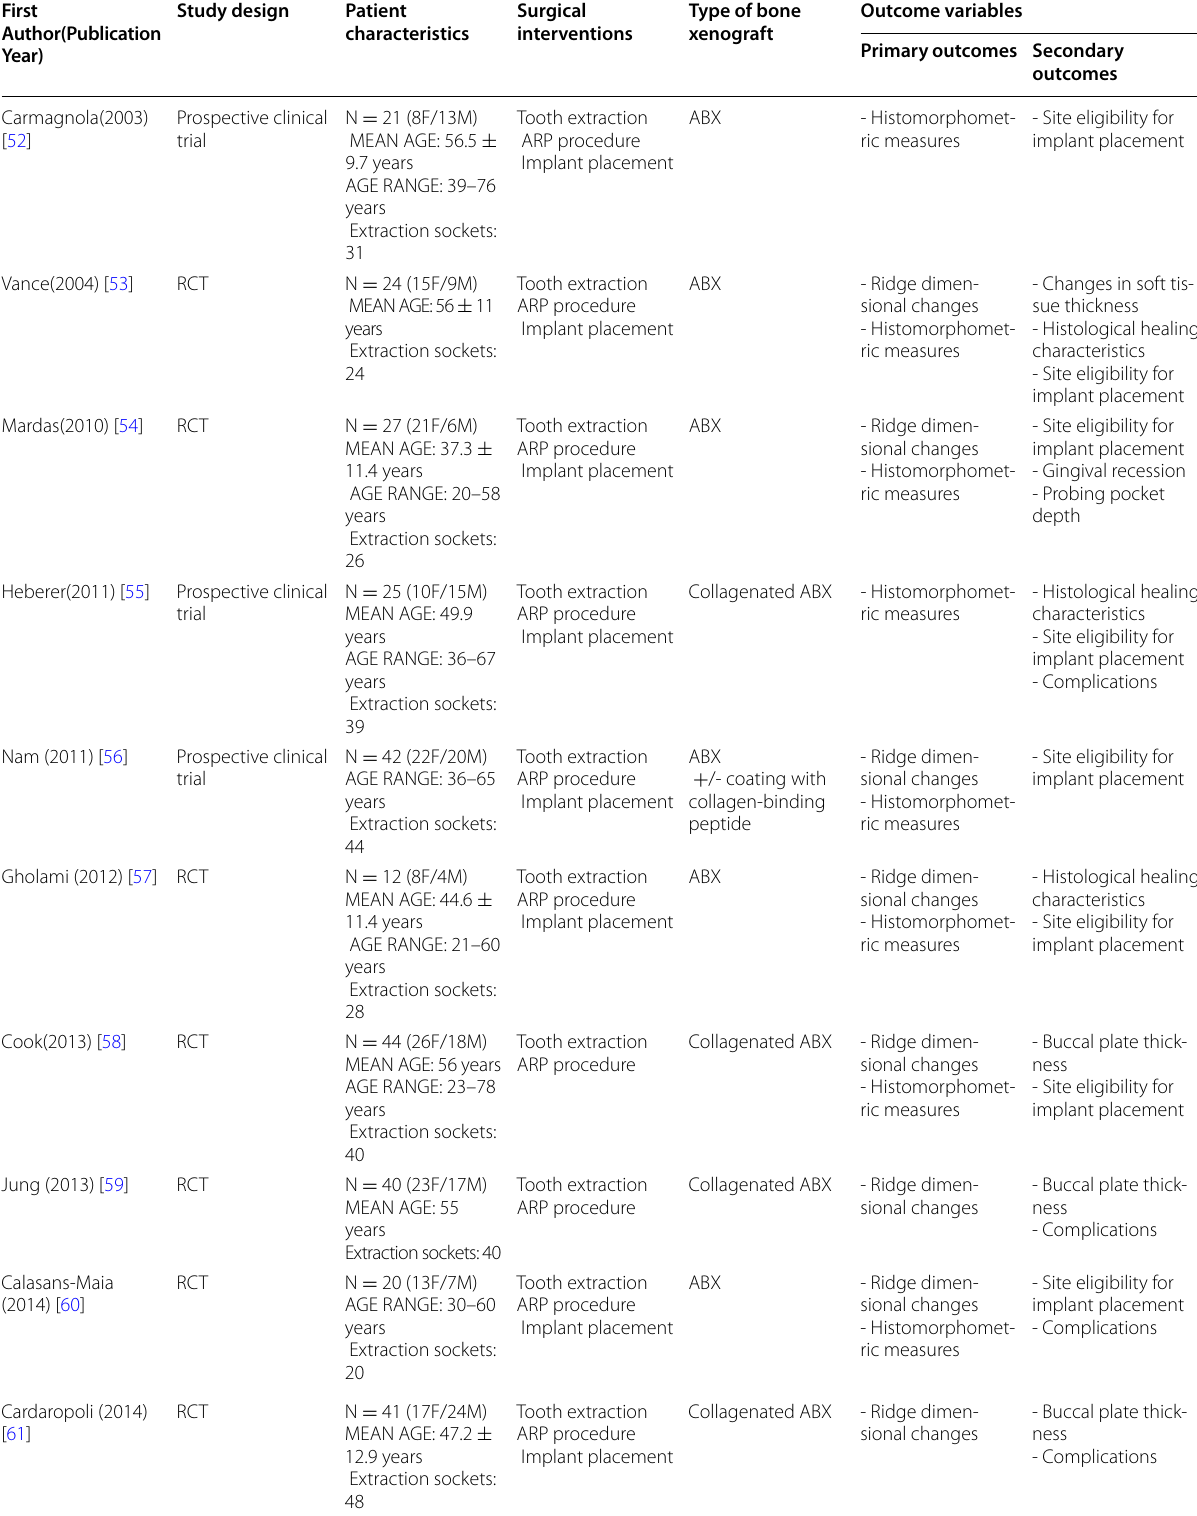
Table 1 Characteristics of the studies included in the systematic review (n